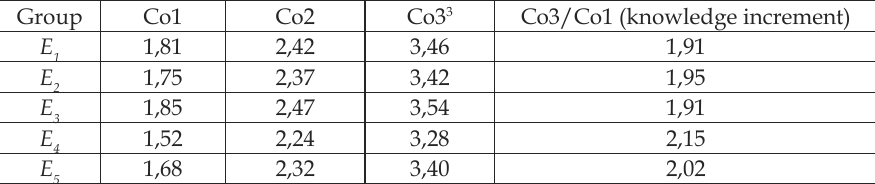
Table 4. Result indices of the properly understood units coef (cid:222) cient on experimen- tal and control groups throughout the whole period of learning